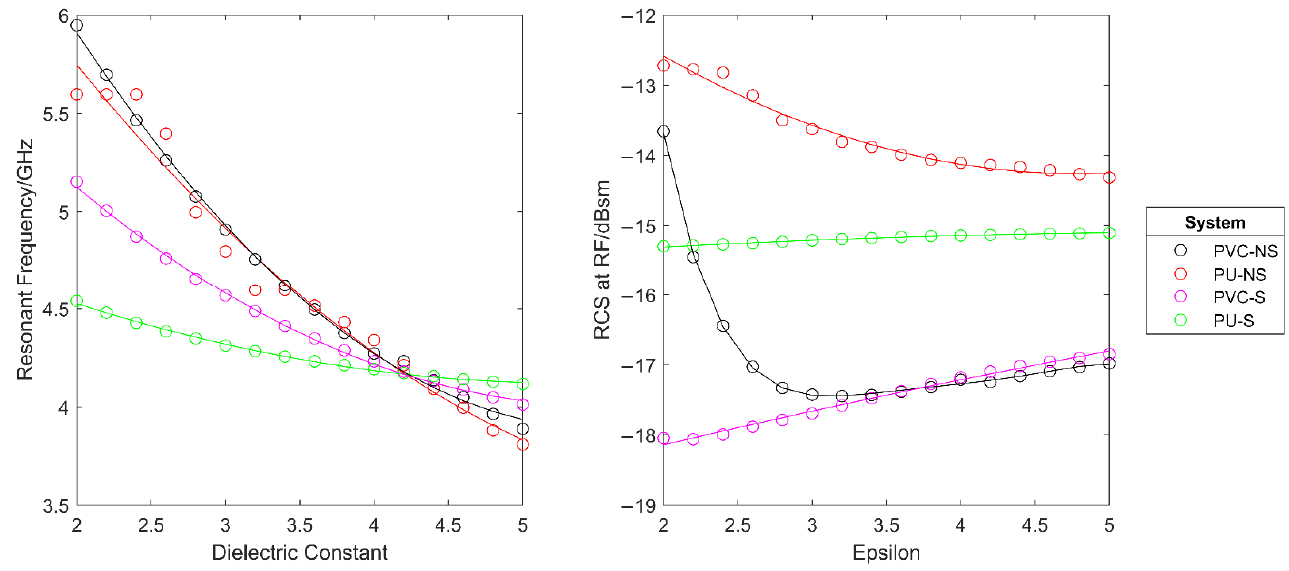
Figure 13. The effect of changes in the dielectric constant of the paint layer on the resonant frequency ( left ) and the RCS at resonant frequency ( right ) of each system.